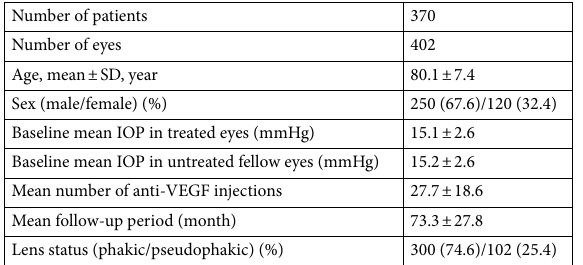
Table 1. Clinical characteristics of the patients with neovascular AMD. AMD age-related macular degeneration, SD standard deviation, IOP intraocular pressure, VEGF vascular endothelial growth factor.